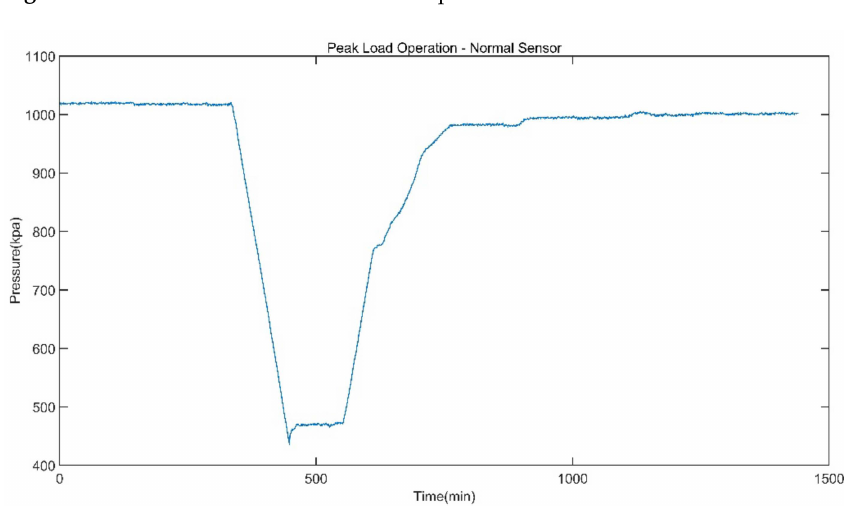
Figure 6. Reheat Steam Pressure of Peak Load